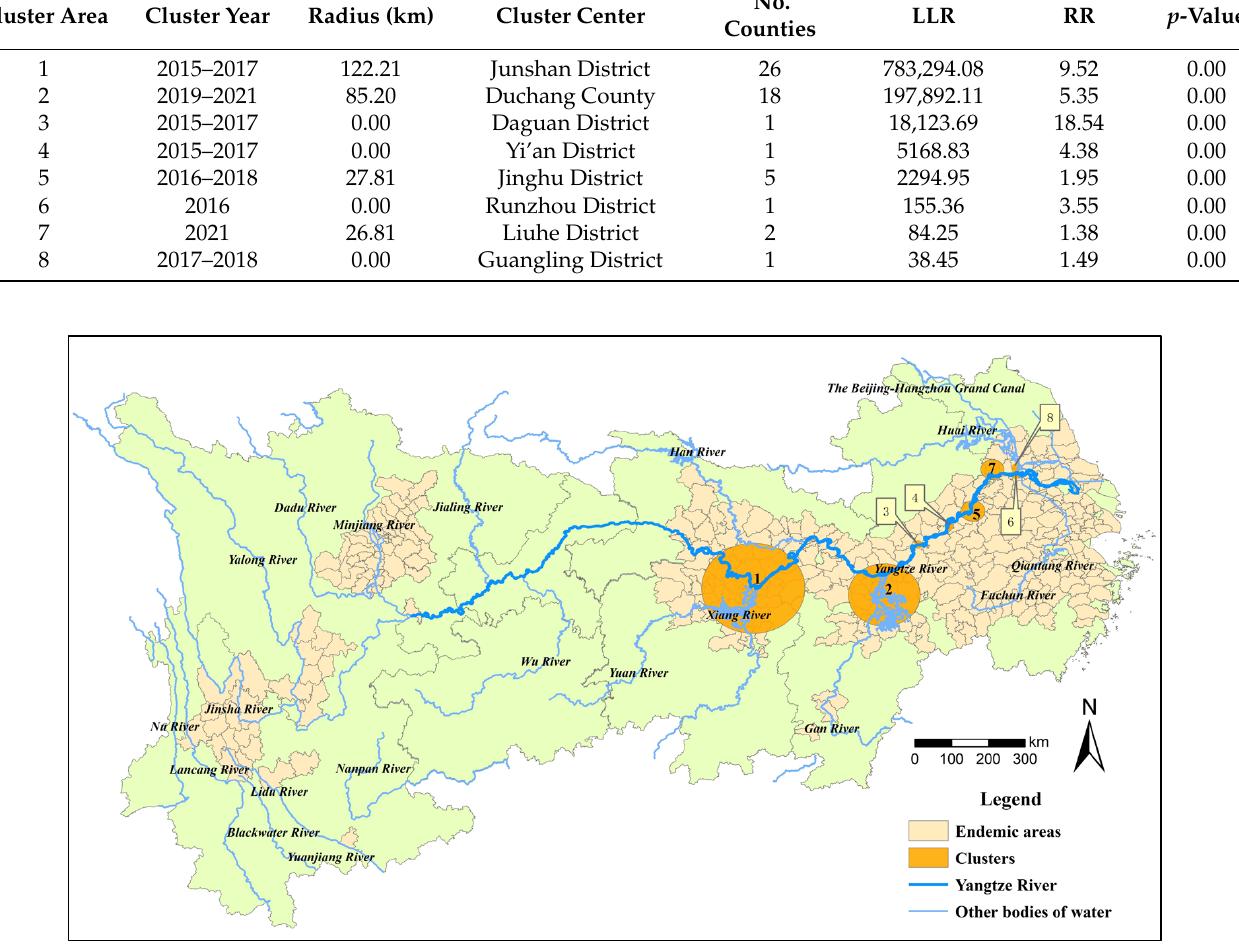
Figure 5. Spatiotemporal cluster areas of snail habitats in the endemic areas in the YEB, 2015–2021.